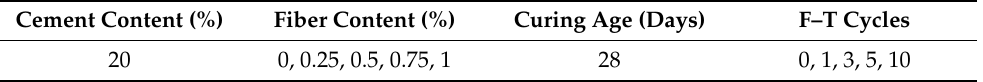
Table 1. UCS test scheme of fiber cement-modified construction slurry tested during F–T cycles. Cement Content (%)